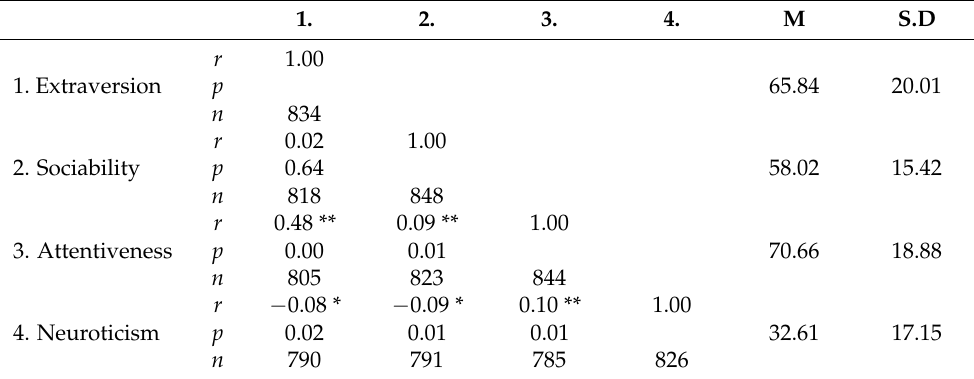
Table 3. Pearson’s correlations between the four personality subscales for ferrets.